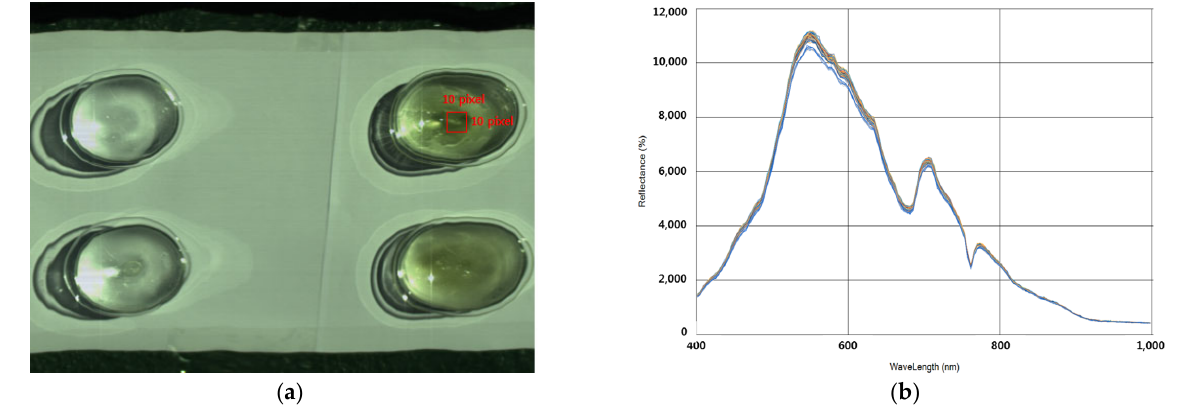
Figure 6. Hyperspectral image extraction method (( a ) region of interest—pixel range setting; ( b ) hyperspectral system—100 spectra for each pixel).